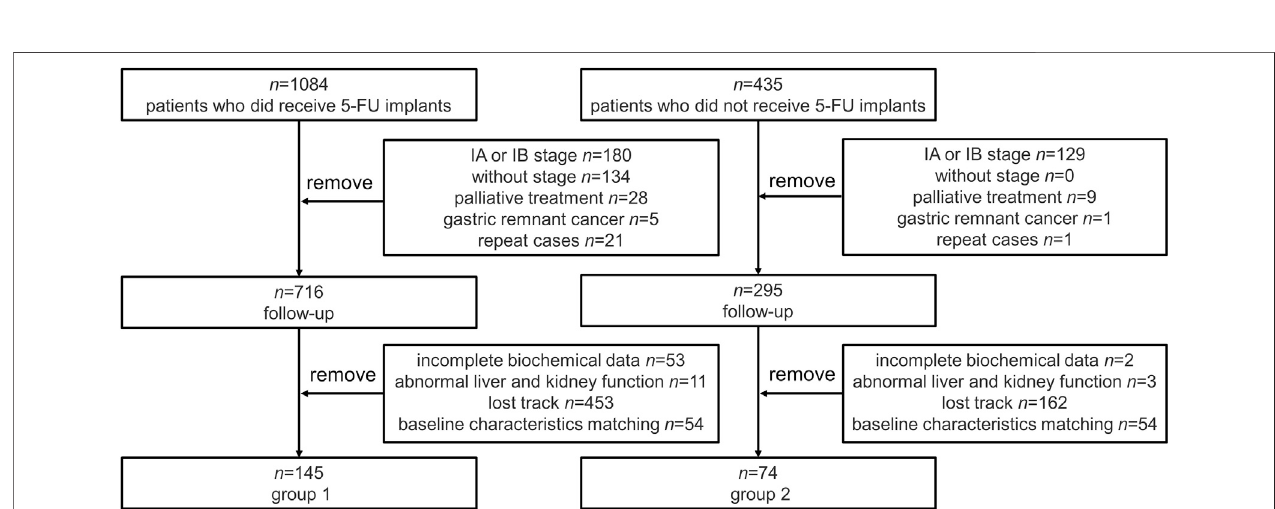
Frontiers in Pharmacology |